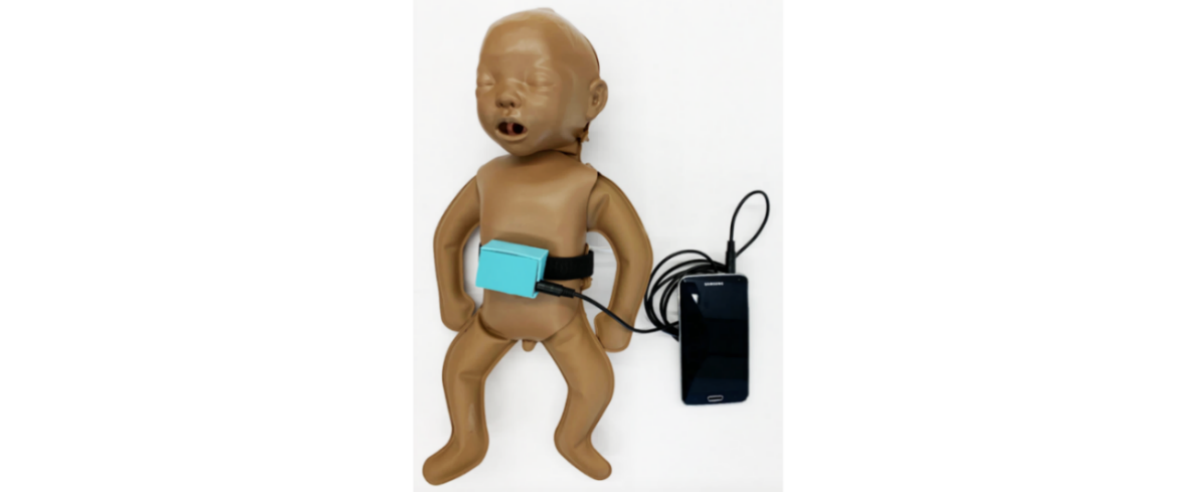
Figure 1. Smartphone connected by an audio cable to the NeMo band on a neonatal